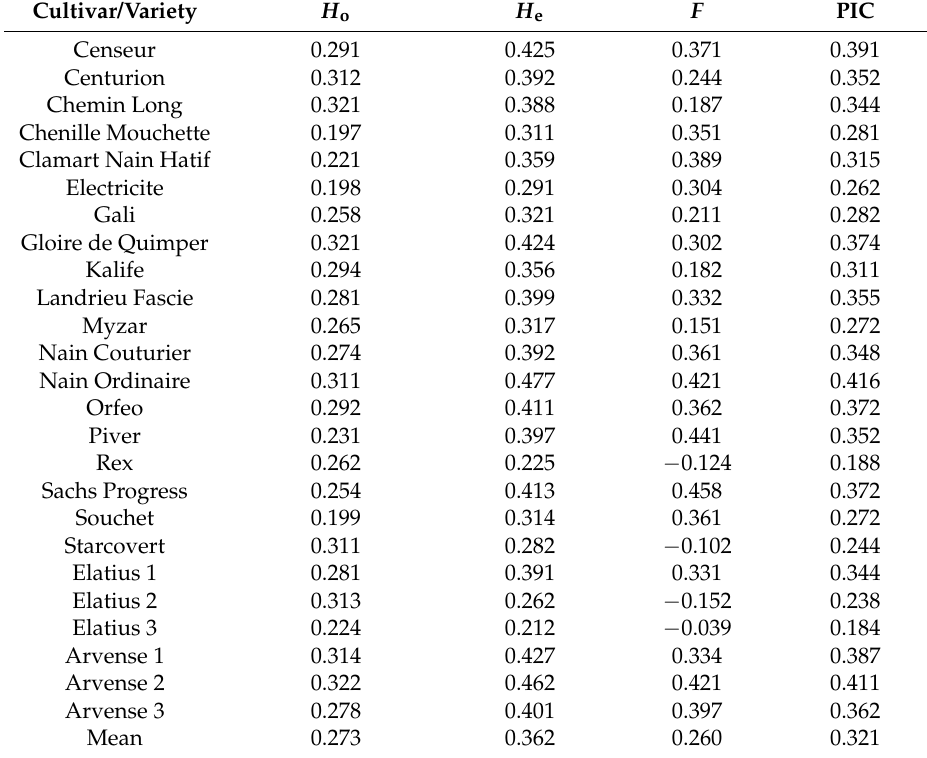
Table 3. Genetic diversity indices of the 25 varieties of Pisum sativum